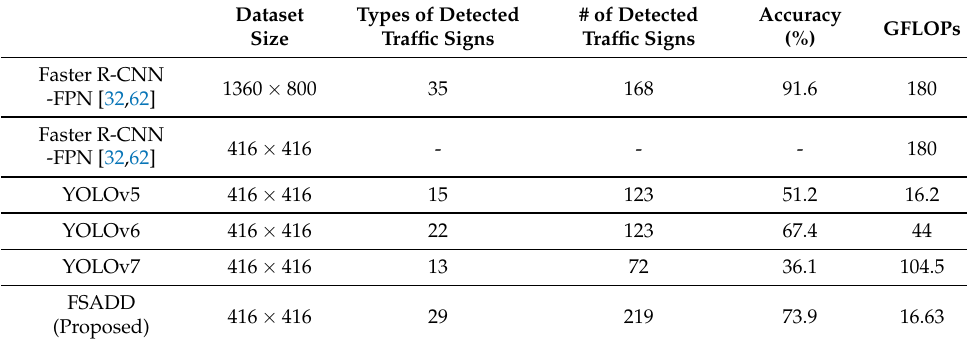
Table 8. Traffic sign recognition comparisons using